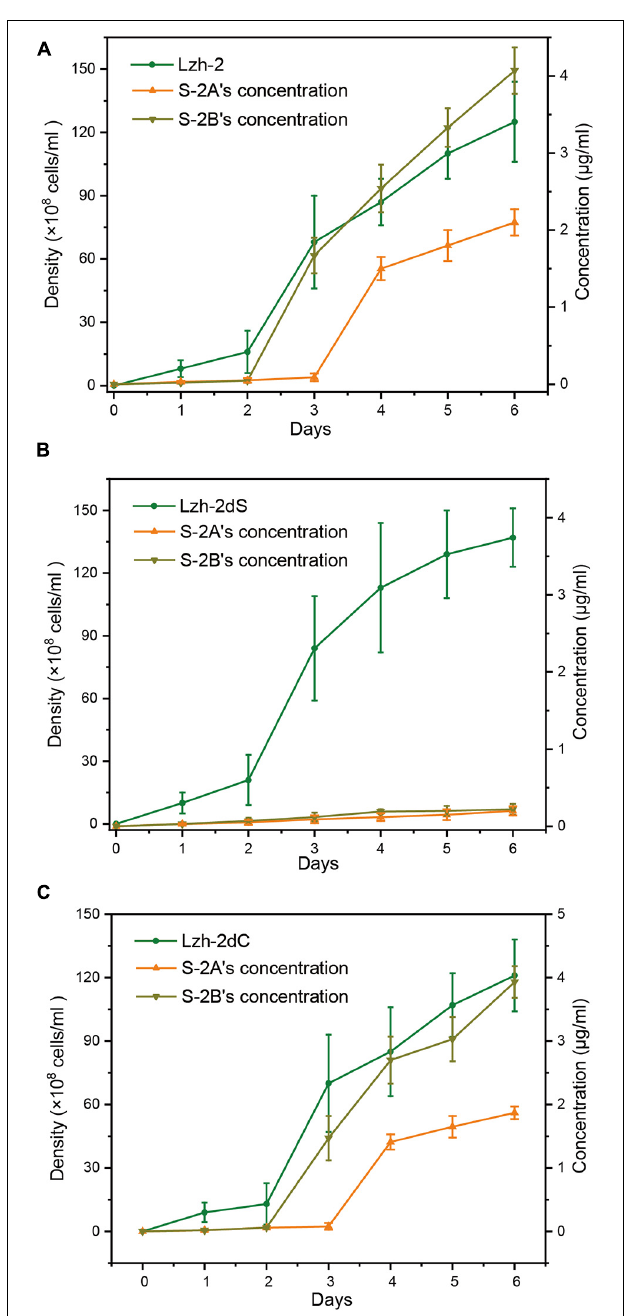
FIGURE 4 | Density of different strains of Shewanella xiamenensis (green) and the corresponding concentration of S-2A (orange) and S-2B (dark yellow). (A) Lzh-2 strain; (B) Lzh-2dS strain; (C) Lzh-2dC